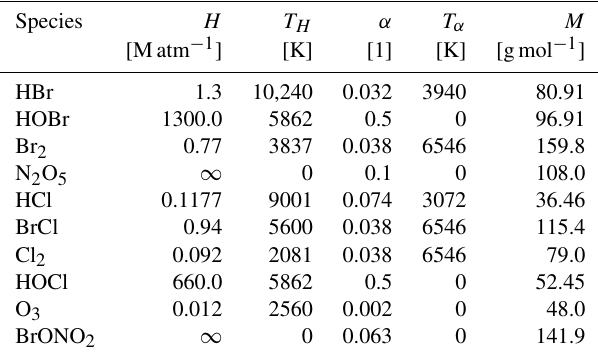
Table A3. Gas–aerosol mass transfer constants.